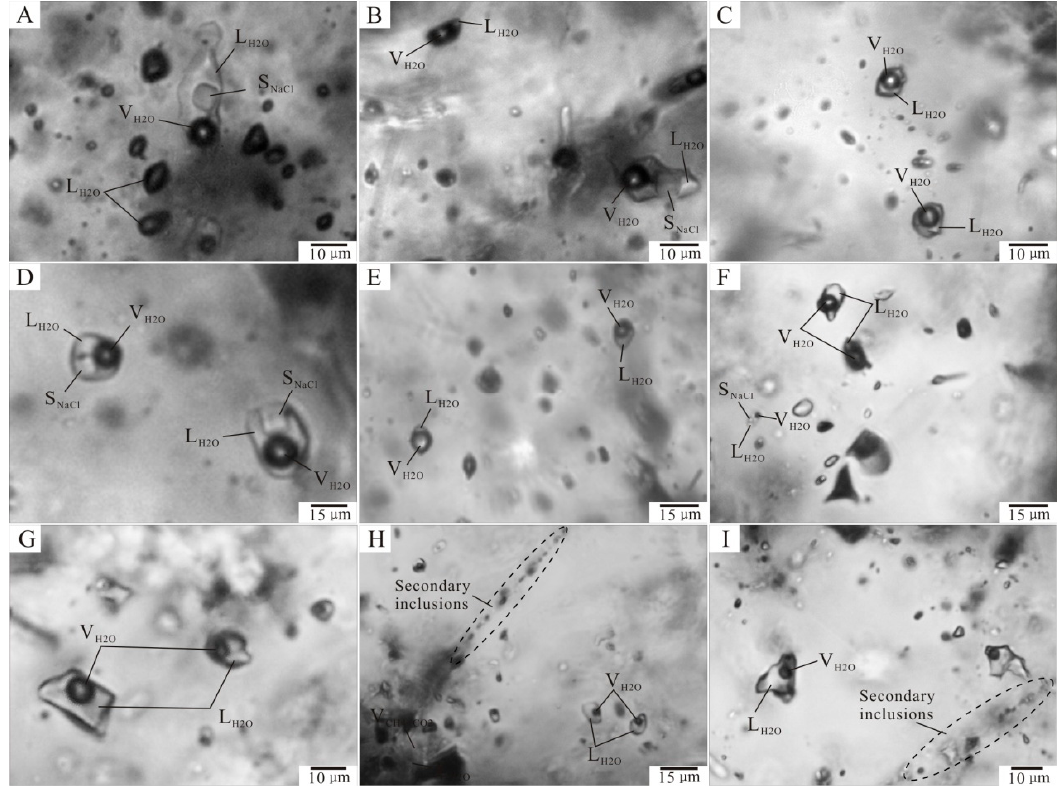
Figure 7. Photomicrographs of FIs in the Qibaoshn polymetallic ore field. ( A – C ) Liquid-rich aqueous (LV) type, halite-bearing (S) type, and vapor-rich aqueous (V) type fluid inclusions (FIs) in quartz from the Jinxiantou deposit; ( D – F ) S type, LV type, and V type FIs in quartz from the Changgou deposit; ( G ) LV type FIs in quartz from the Xingshanyu deposit; and ( H – I ) LV type FIs in quartz from the Hongshigang deposit. Abbreviations: L (liquid phase), V (vapor phase), S (halite